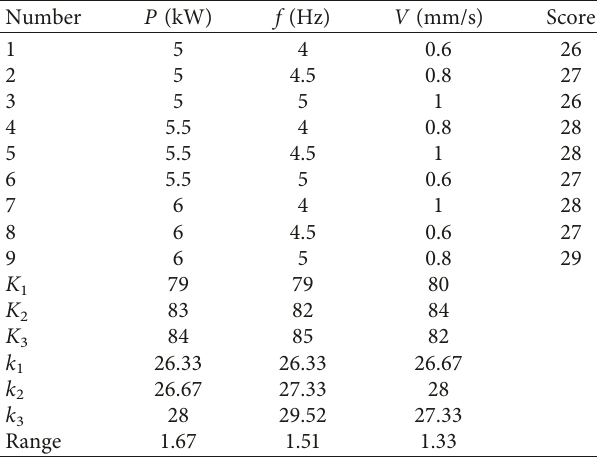
Table 4: The results of the orthogonal